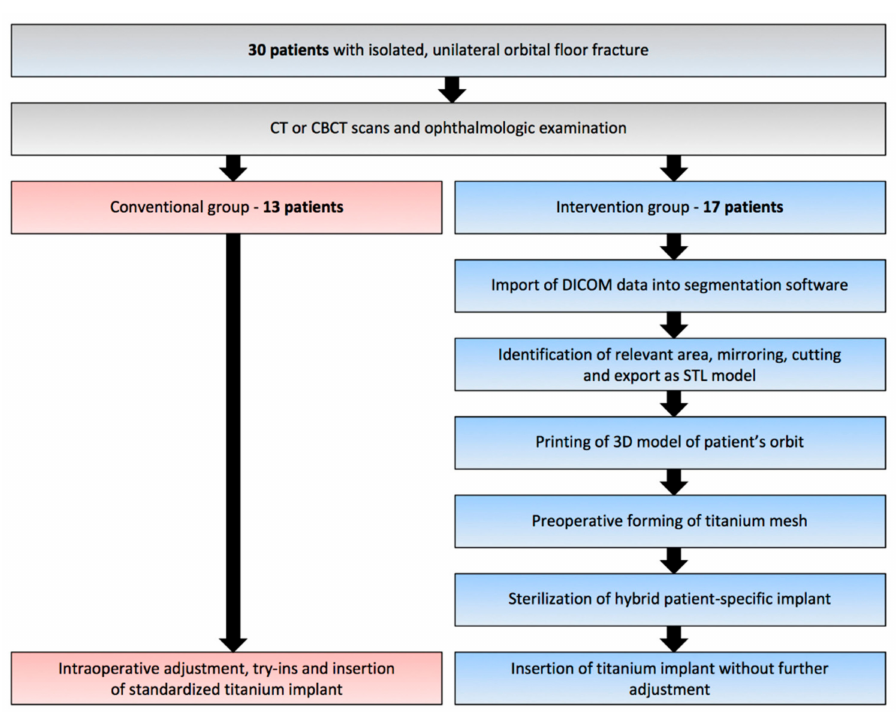
Figure 1. Study design and treatment